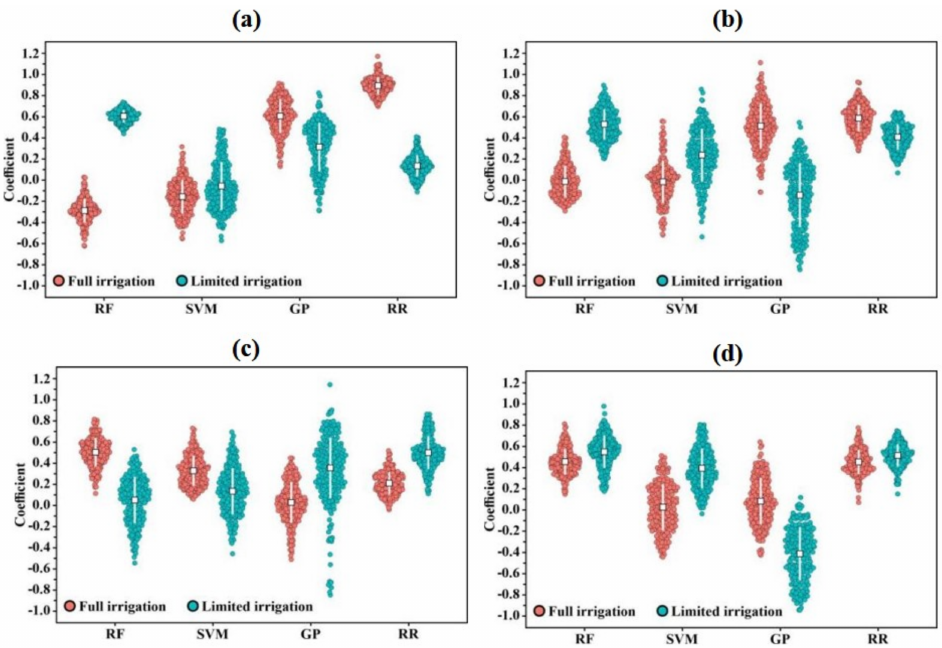
Figure 11. The distribution of regression coefficient within the level-2 model (MLR); ( a ) heading stage; ( b ) flowering stage; ( c ) early gain filling stage; ( d ) mid gain filling stage. Abbreviations: RF, random forest; SVM; support vector machine; GP, Gaussian process; and RR, ridge